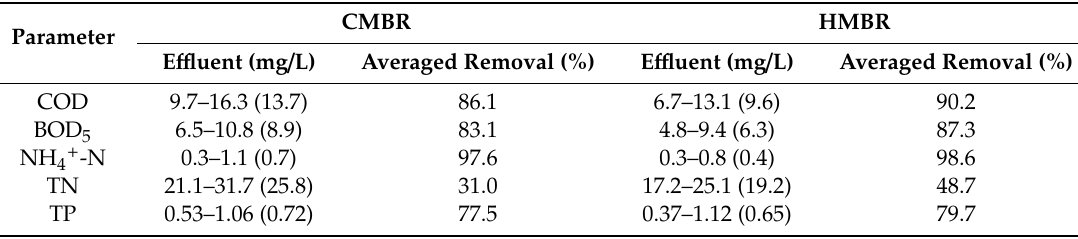
Table 2. Performance of conventional membrane bioreactor (CMBR) and hybrid membrane bioreactor (HMBR) on organic and nutrients removals.